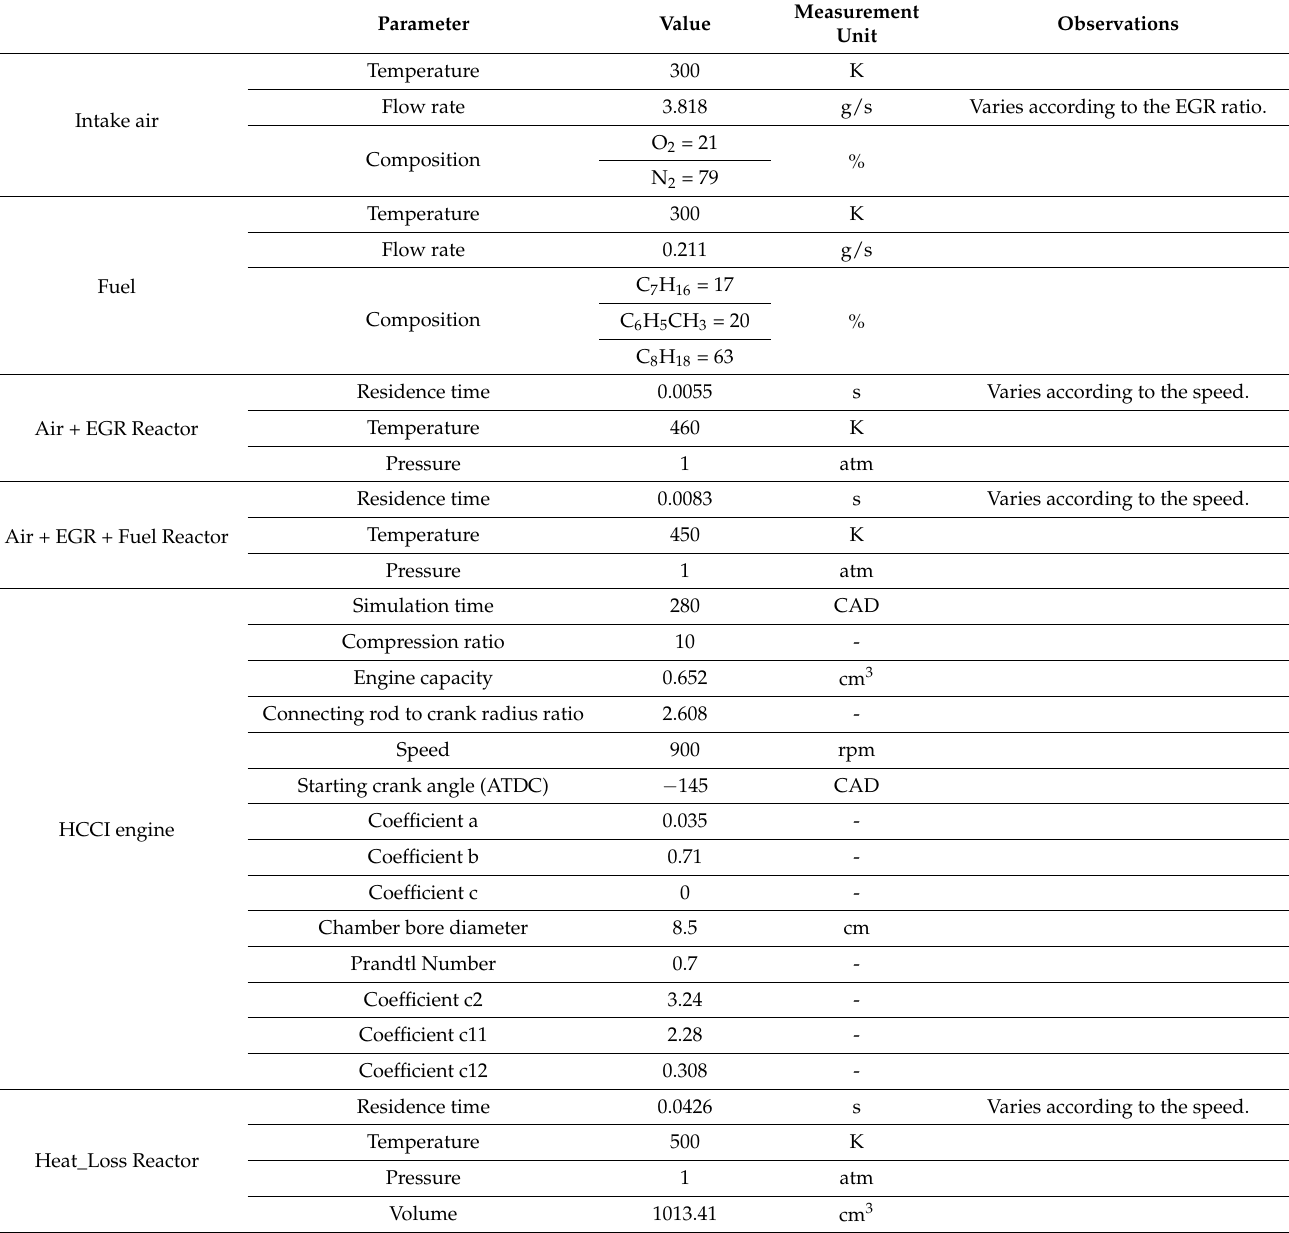
Table 3 lists all input data that were entered for simulating the HCCI engine. Table 3. Input data for simulating the HCCI